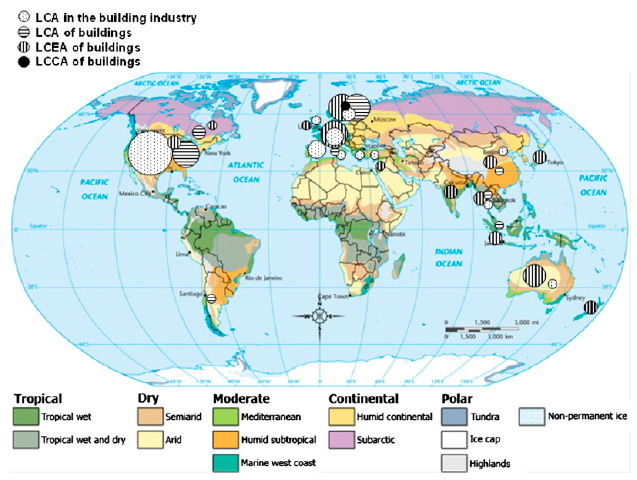
Figure 8. Geographic concentration of LCA studies carried out across the world.